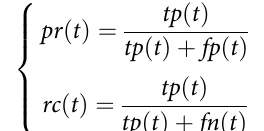
S1 Fig. The mean AUROC values of GO terms versus 12 GO prediction methods in four ranges. (a) range 5–10. (b) range 10–30. (c) range 30–50. (d) range > 50. S2 Fig. The median AUROC values of GO terms versus 12 GO prediction methods in four ranges. (a) range 5–10. (b) range 10–30. (c) range 30–50. (d) range > 50. S3 Fig. The distributions of AUROC values for GO terms in two ranges versus 12 GO pre- diction methods, where the median line in the box is the median AUROC value. (a) range 30–50. (b) range > 50. S4 Fig. The AUPR values of 10 GO prediction methods under the sequence identity cut-off t 1 = 30% for three GO aspects on four individual species in CAFA3 test dataset. (a)